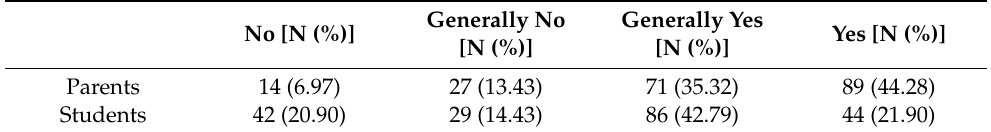
Table 10. Disinfecting hands in public